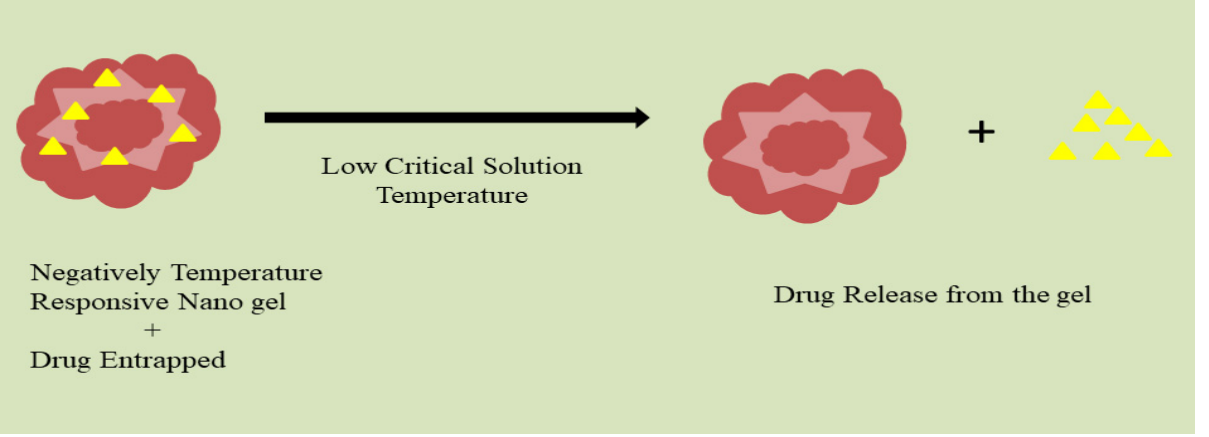
Figure 4. Temperature responsive nanogels and drug release from the thermogel.